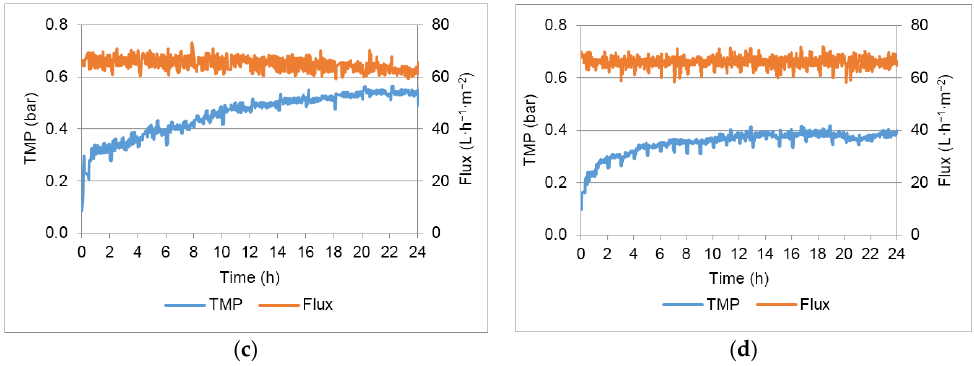
Figure 3. TMP and flux profiles obtained in the different assays: ( a ) test 1; ( b ) test 2; ( c ) test 3; ( d ) test 4.